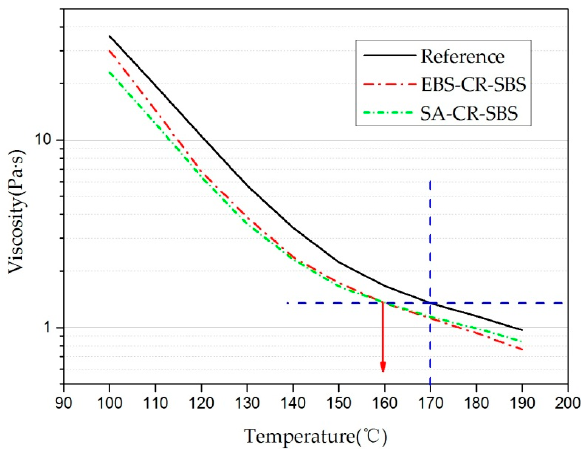
Figure 7. Result of the viscosity test.